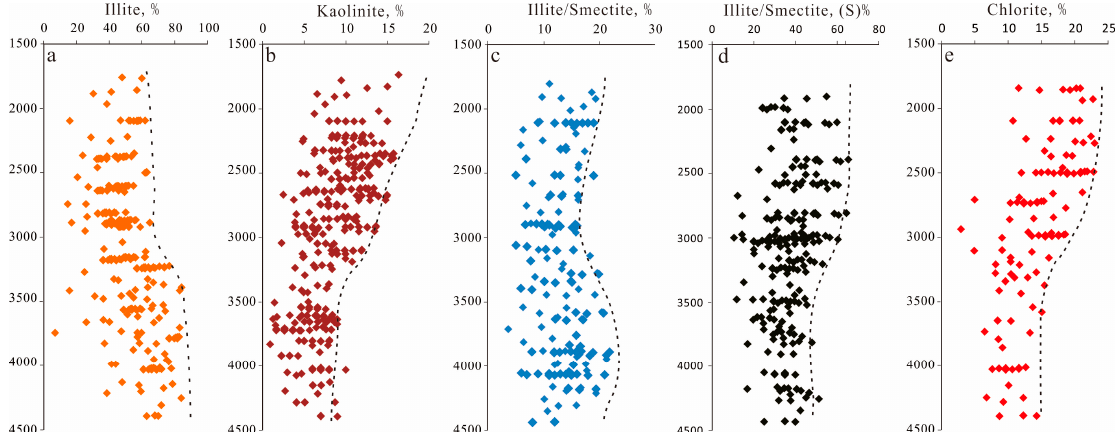
Figure 10. Vertical distribution characteristics of clay minerals in the Lulehe sandstones (From XRD data). ( a ) Cross plot of illite with depth; ( b ) Cross plot of kaolinite with depth; ( c ) Cross plot of mixing layer of illite and smectite with depth; ( d ) Cross plot of the content of smectite in the mixing layer of illite and smectite; ( e ) Cross plot of chlorite with depth. Minerals 2019 , 9 , x FOR PEER REVIEW